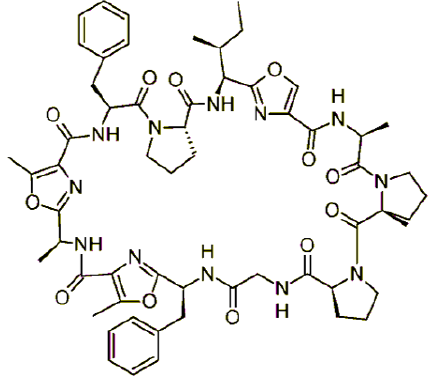
Figure 10. Structure of wewakazole